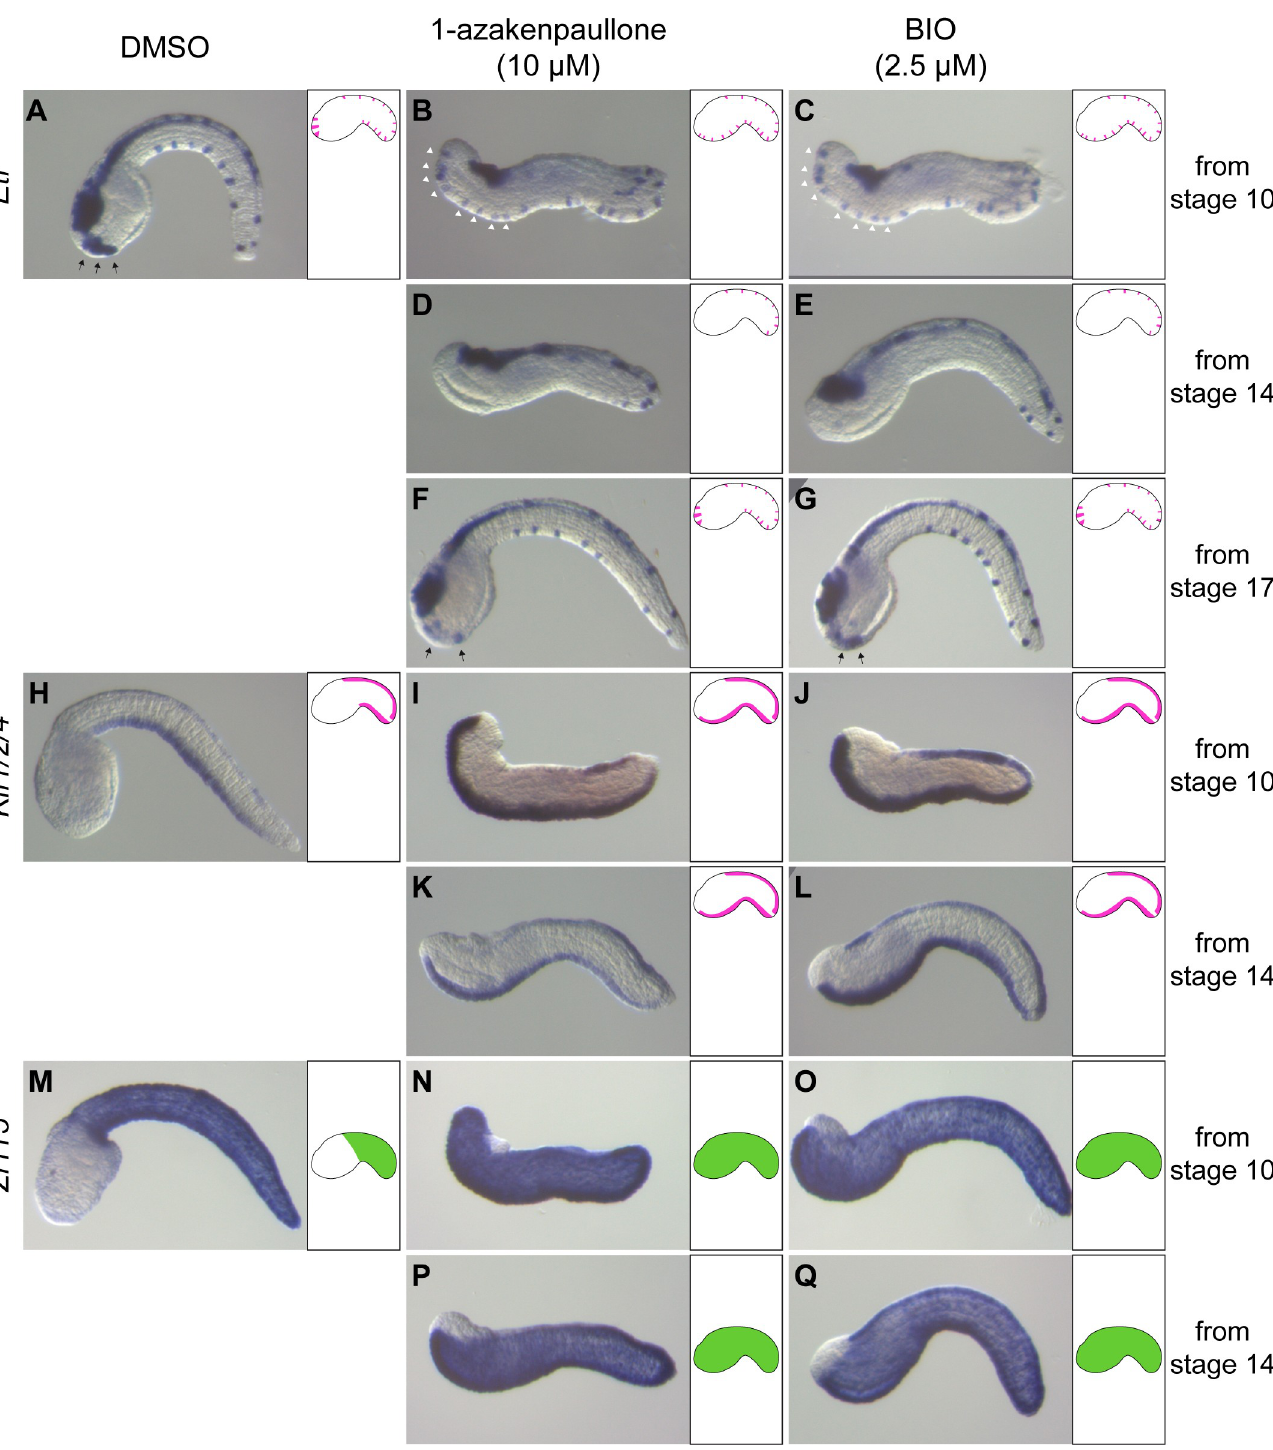
Fig 1. Consequences of activating cWnt at different developmental stages on PNS and epidermis formation. Embryos were treated with 10 μ M 1-azakenpaullone or 2.5 μ M BIO from initial gastrula (stage 10; B, C, I, J, N and O), from early neurula (stage 14; D, E, K, L, P and Q) or from initial tailbud stages (stage 17; F and G) until fixation at late tailbud stages (stages 23/24). Expression of Etr (A-G), Klf1/2/4 (H-L) and Zf115 (M-Q) was determined by in situ hybridization. Black arrows point to palp neurons, white arrowheads indicate ectopic Etr staining in the ventral trunk epidermis midline. Embryos are oriented with dorsal to the top and anterior to the left. On the right side of each picture, a schematic embryo depicts our interpretation of the expression pattern according to each tissue: PNS (pink at the top) and epidermis (green in the middle). Number of experiments: one for B, C, F, G, K and L; two for A, D, E, H, I, J and M to Q.